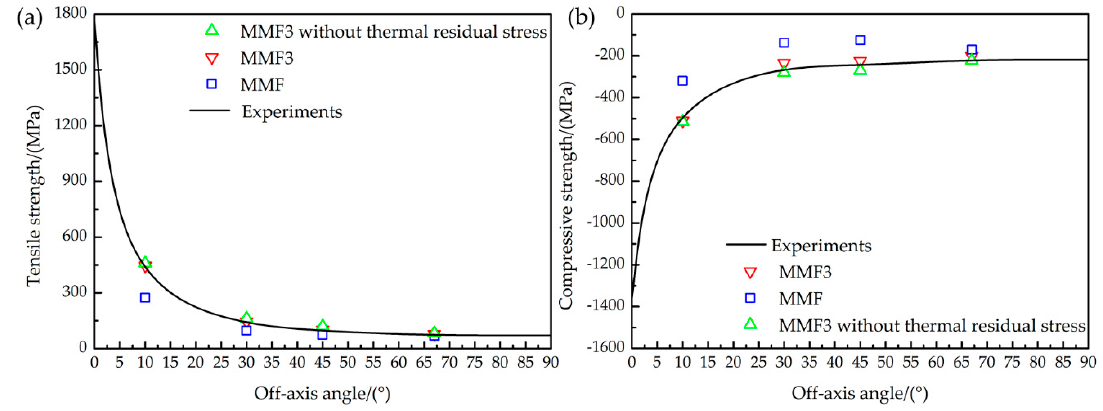
Figure 6. Strength comparison between experimental and numerical results: ( a ) Off-axis tension; ( b ) Off-axis compression.